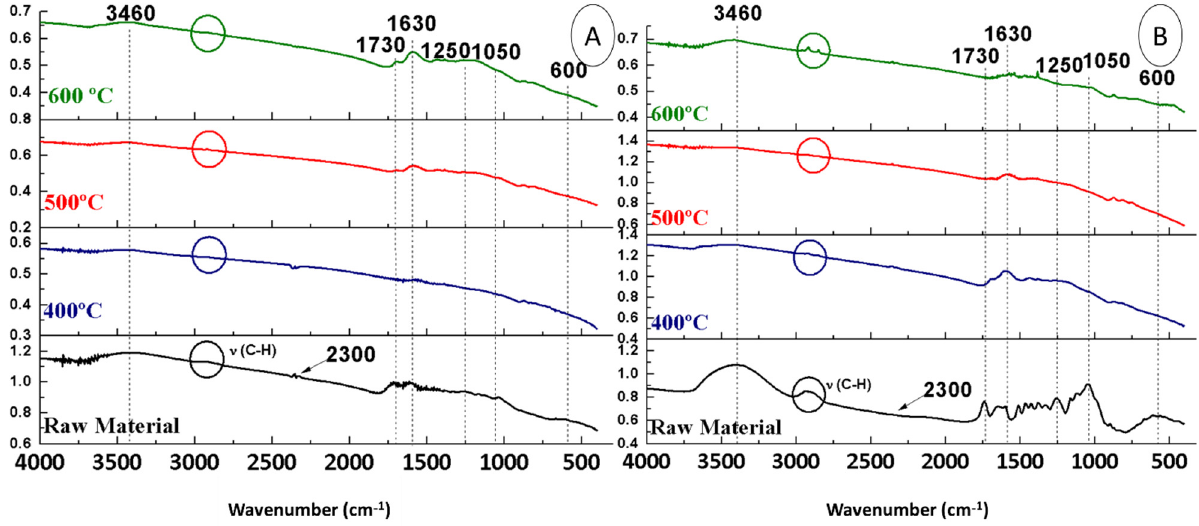
Figure 3. FTIR spectra of biochars from OS + H 2 SO 4 ( A ) and OS ( B ) at different